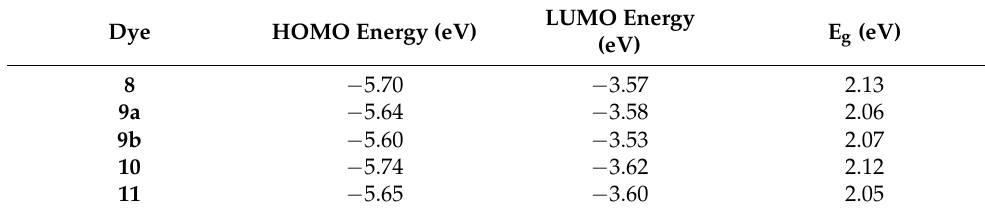
Table 3. Electrochemical properties in dimethylformamide (DMF) obtained from DPV measure- ments: HOMO energy level, determined from the onset of the oxidation peak (E ox ); LUMO energy level, determined from the onset of the reduction peak (E red ). Gap energy (E g ), calculated with E HOMO —E LUMO